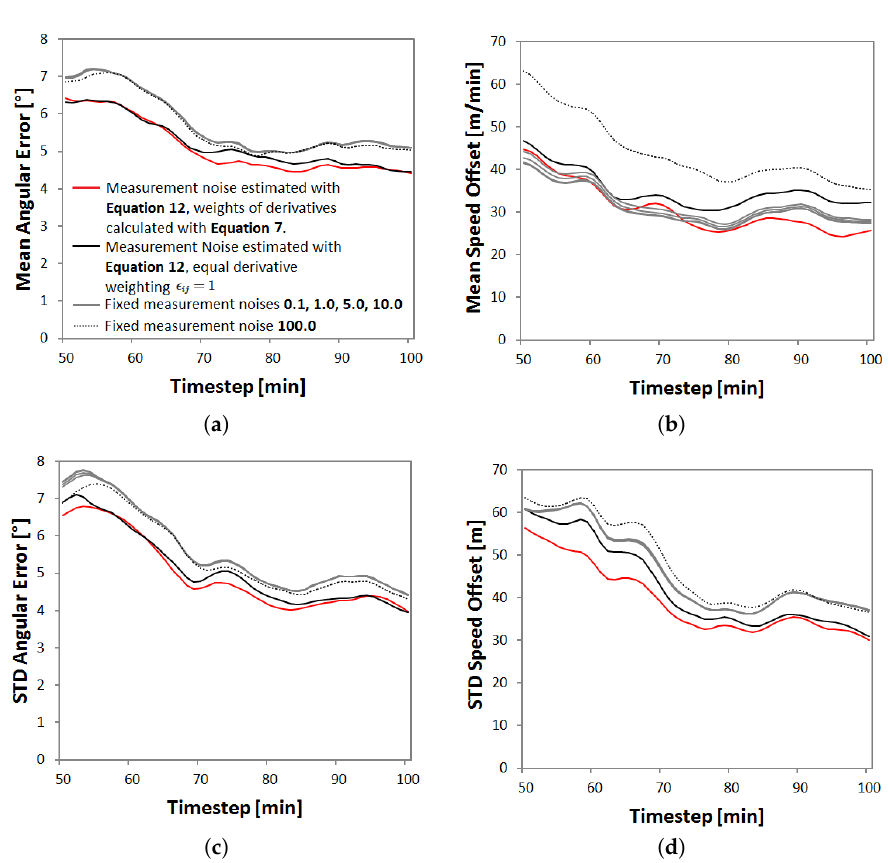
Figure 7. Comparison of the angular and speed offset for different Kalman filer measurement noise parameters. ( a ) Mean angular error; ( b ) mean speed offset; ( c ) standard deviation angular error; ( d ) standard deviation speed